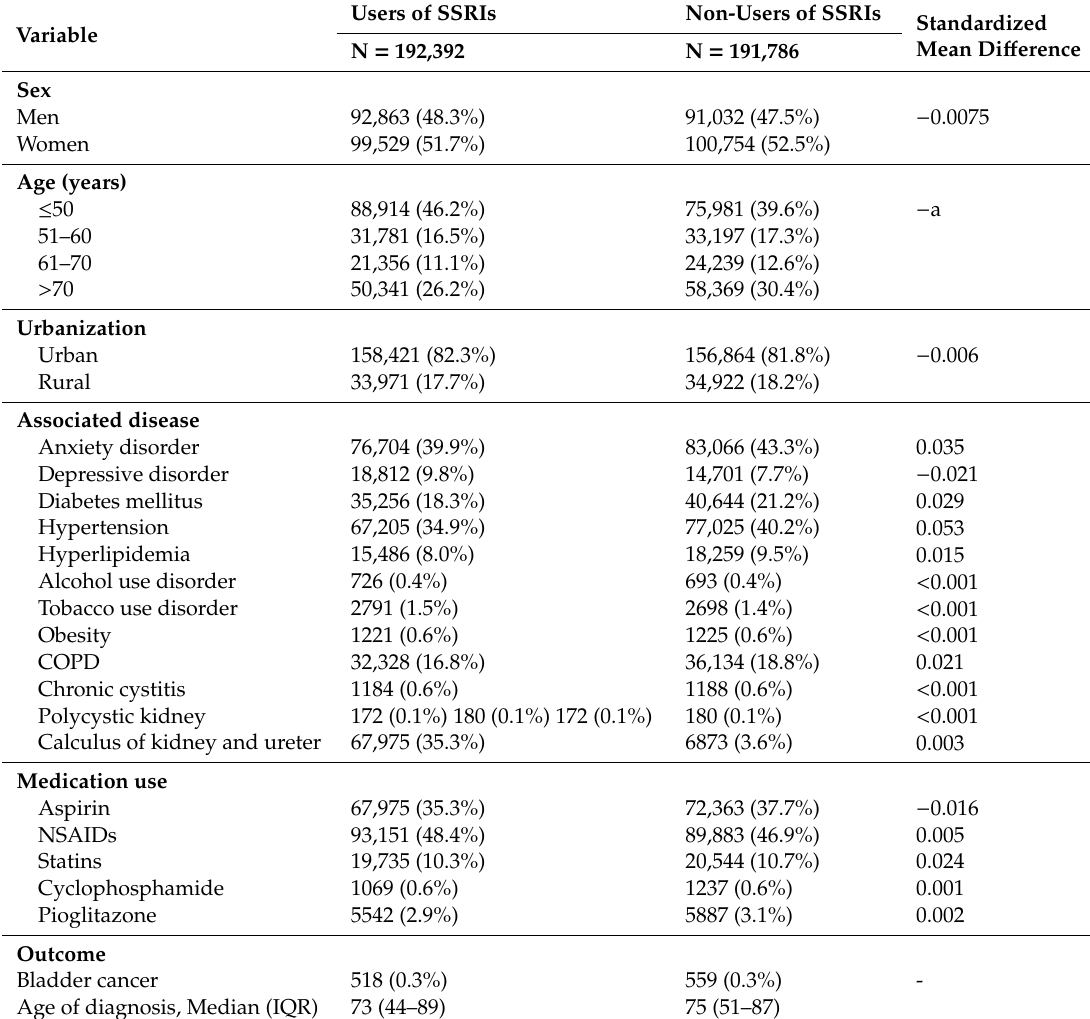
Table 1. Comparison of demographic characteristics and medical diseases in patients with or without selective serotonin reuptake inhibitors (SSRIs) after propensity score matching.